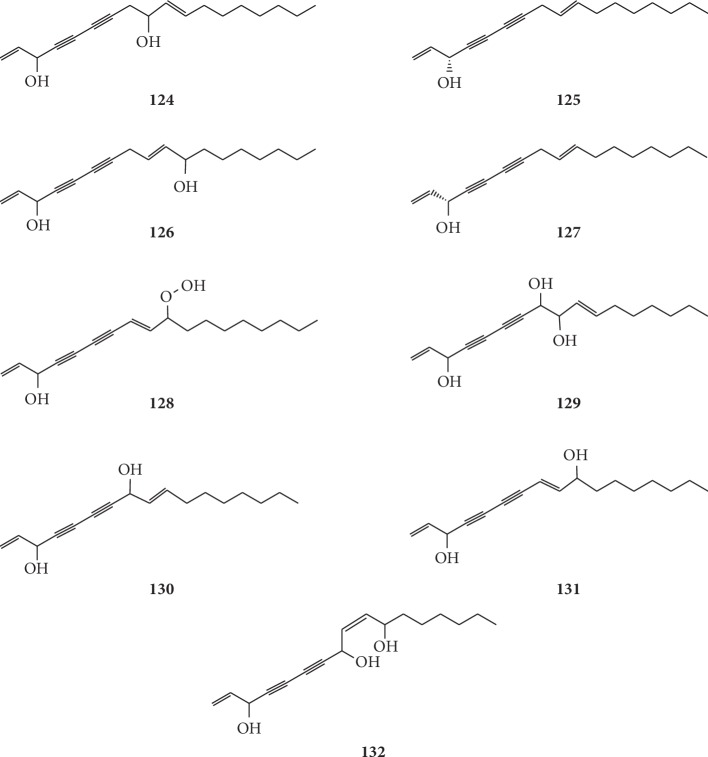
Structures of terpenoids in G. littoralis.